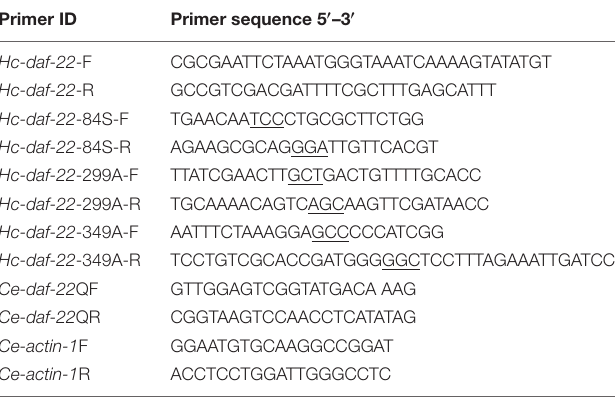
TABLE 1 | Primers used in this study. Primer ID Primer sequence 5 (cid:48) –3